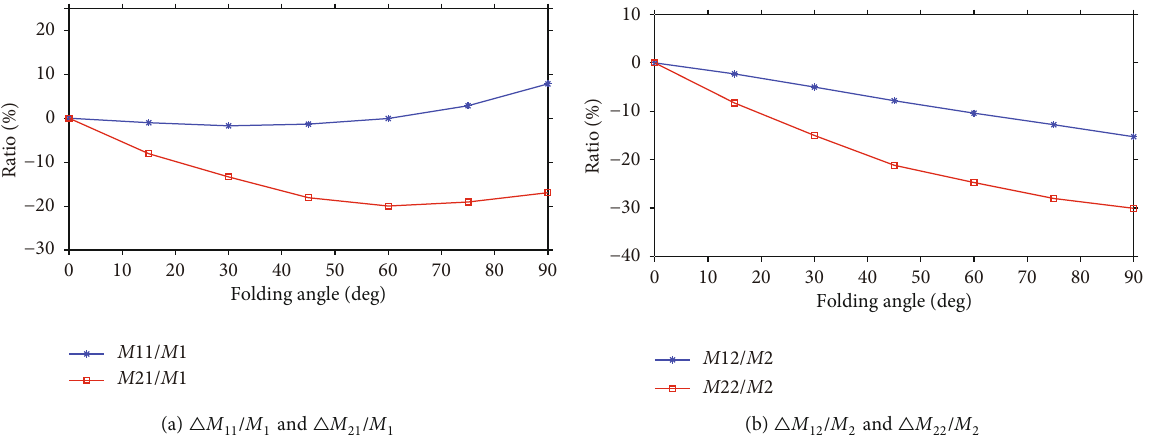
Figure 17: In fl uence of two ways on the hinge moments.